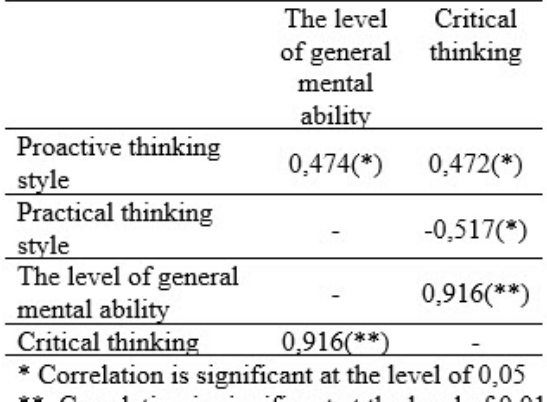
Table 4. Correlation analysis of style characteristics of students-eSports players